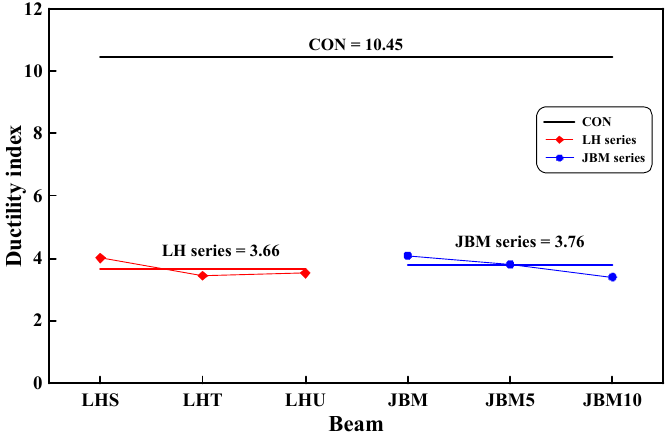
Figure 8. Variation in ductility index.